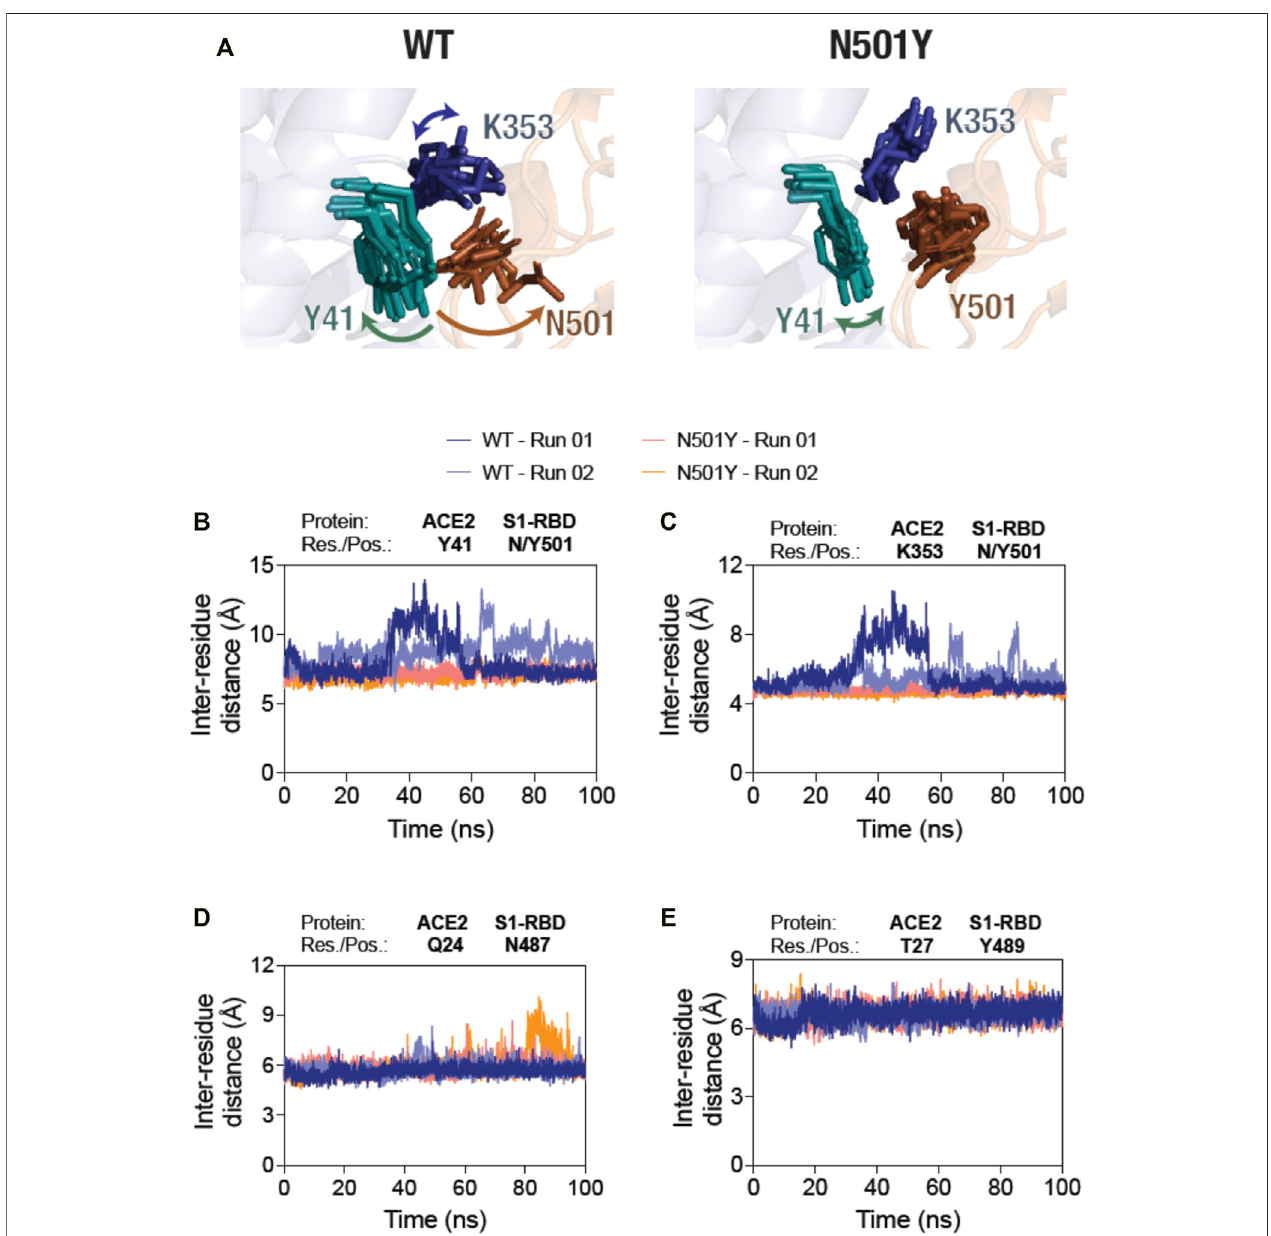
FIGURE 2 | Sustained interaction of S1-RBD Y501 residue (N501Y mutant) with ACE2. (A) Temporal evolution of residues Y41 and K353 in ACE2 and either the N501 in the WT S1-RBD (left panel) or the Y501 in the N501Y mutant S1-RBD (right panel) in the MD simulation. A total of 11 frames obtained from up to 100 s simulations, each 10 ns apart, were compiled together. Note the increased fl uctuation of the N501 residue in the WT S1-RBD. (B – E) Graph showing inter-residue distances between the center of masses of residue Y41 in ACE2 and N501 in the WT and Y501 in the N501Y mutant S1-RBD (B) , K353 in ACE2 and N501 in the WT and Y501 intheN501Y mutant S1-RBD (C) , Q24inACE2 and N487 in eithertheWT or theN501YmutantS1-RBD (D) , and T27inACE2 and Y489in eithertheWT or the N501Y mutant S1-RBD (E) . Note the increased inter-residue distance fl uctuations between the residues Y41 and K353 in ACE2 and N501 in S1-RBD in the WT ACE2-S1-RBD complex compared to the N501Y mutant complex (B,C)